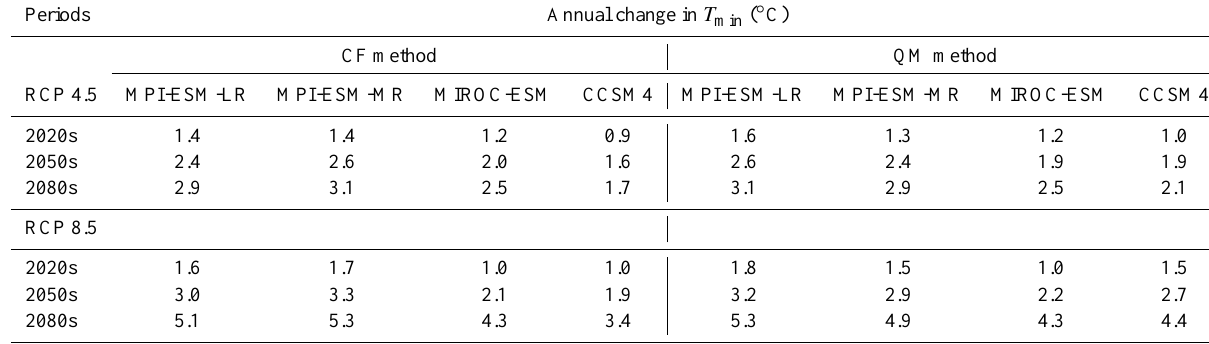
Table 6. Annual changes in T min in the future under the four GCMs and two scenarios (RCP4.5 and RCP8.5). Periods Annual change in T min ( ◦ C) CF method